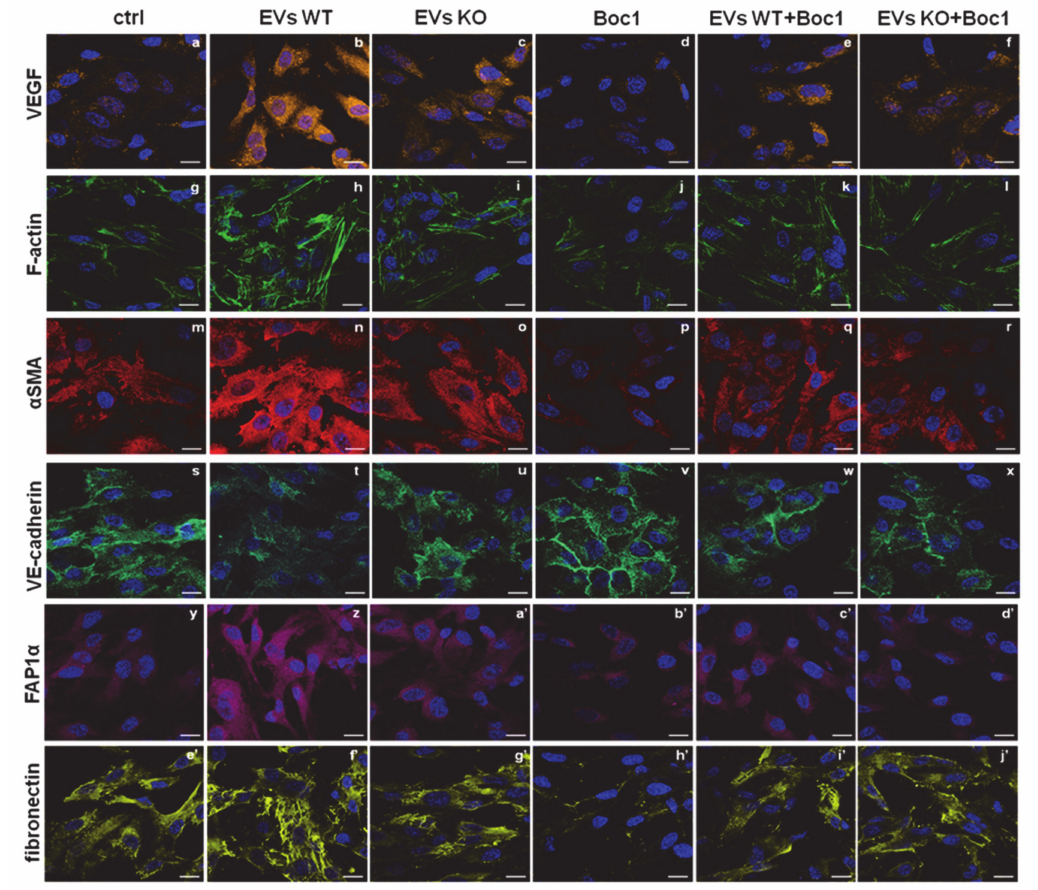
Figure 6. EndMT induced by ANXA1-containing EVs. Confocal analysis for HUVEC cells in the presence of WT and ANXA1 KO EVs with and without Boc-1 for: VEGF (panels a – f ), F-actin (panels g – l ), α SMA (panels m–r), VE-cadherin (panels s – x ), FAP1 α (panels y – d’ ), fibronectin (panels e’ – j’ ). Nuclei were stained with Hoechst 33,342 1:1000 for 30 min at RT in the dark. Magnification 63 × 1.4 NA. Bar = 100 µ